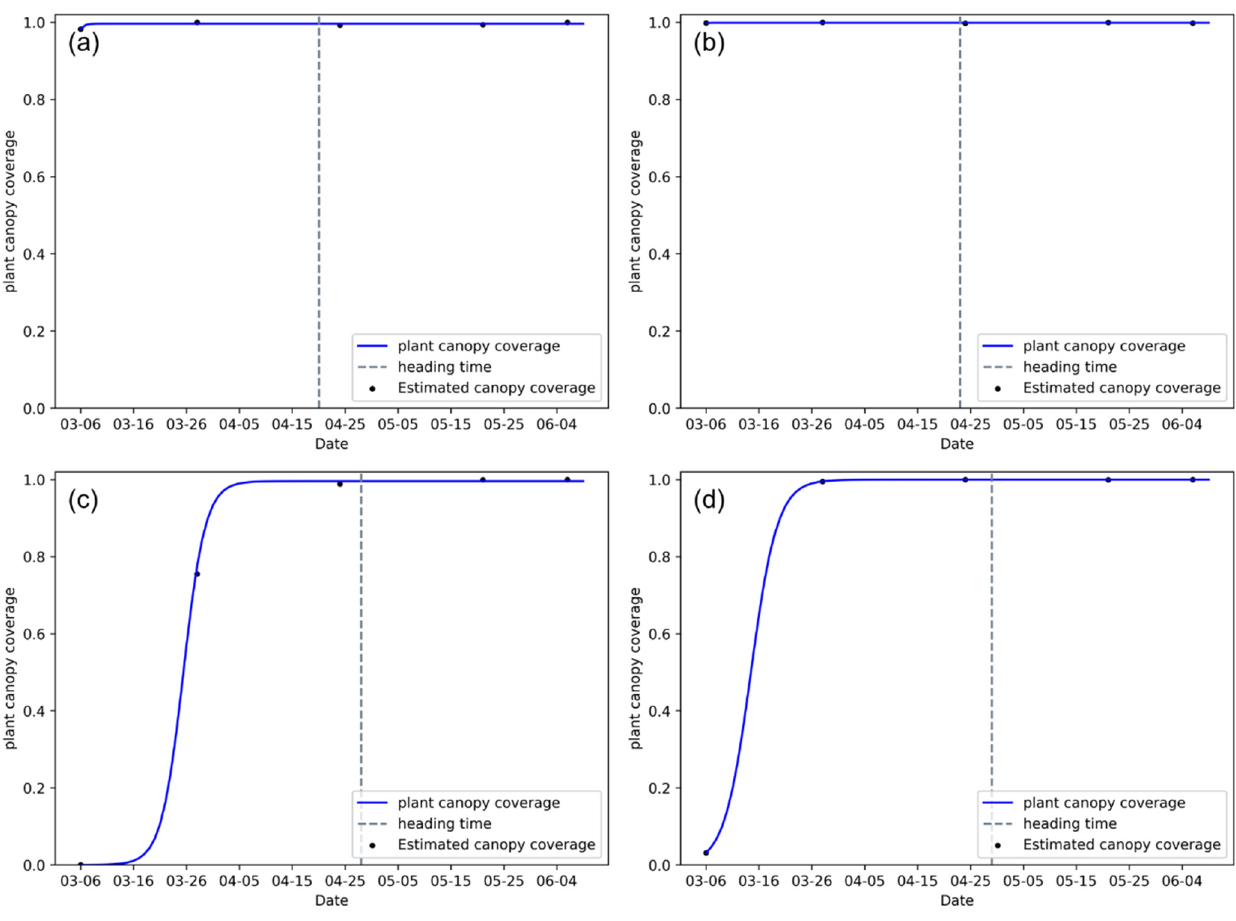
Figure 4. Canopy coverage growth curve. ( a ) early sowing-low density plot (sowing date: 5 October; variety: Zhoumai 18; density: 1.5 million plants/ha), ( b ) early sowing-high density plot (sowing date: 5 October; variety: Zhoumai 18; density: 7.5 million plants/ha), ( c ) late sowing-low density plot (sowing date: 25 November; variety: Zhoumai 18; density: 1.5 million plants/ha), ( d ) late sowing-high density plot (sowing date: 25 November; variety: Zhoumai 18; density: 7.5 million plants/ha). Gray dashed line indicates the heading date recorded in the field.